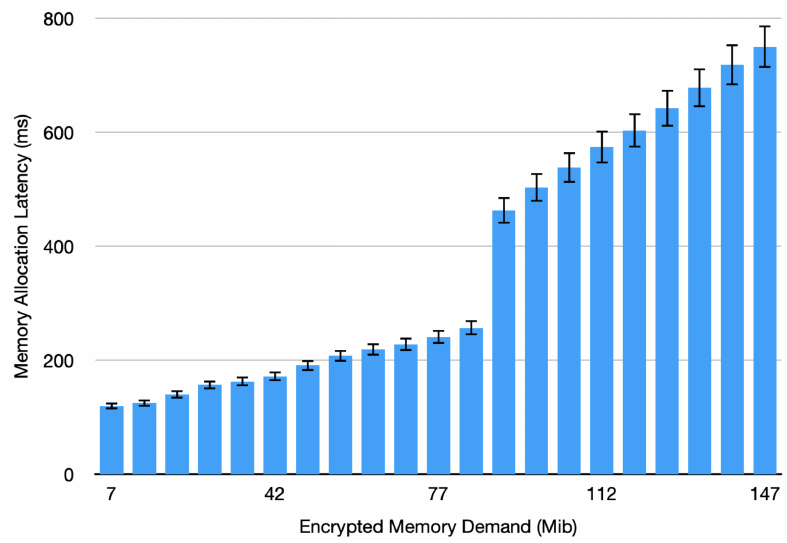
Figure 3. Memory allocation overhead on SGX with increased Encrypted Memory